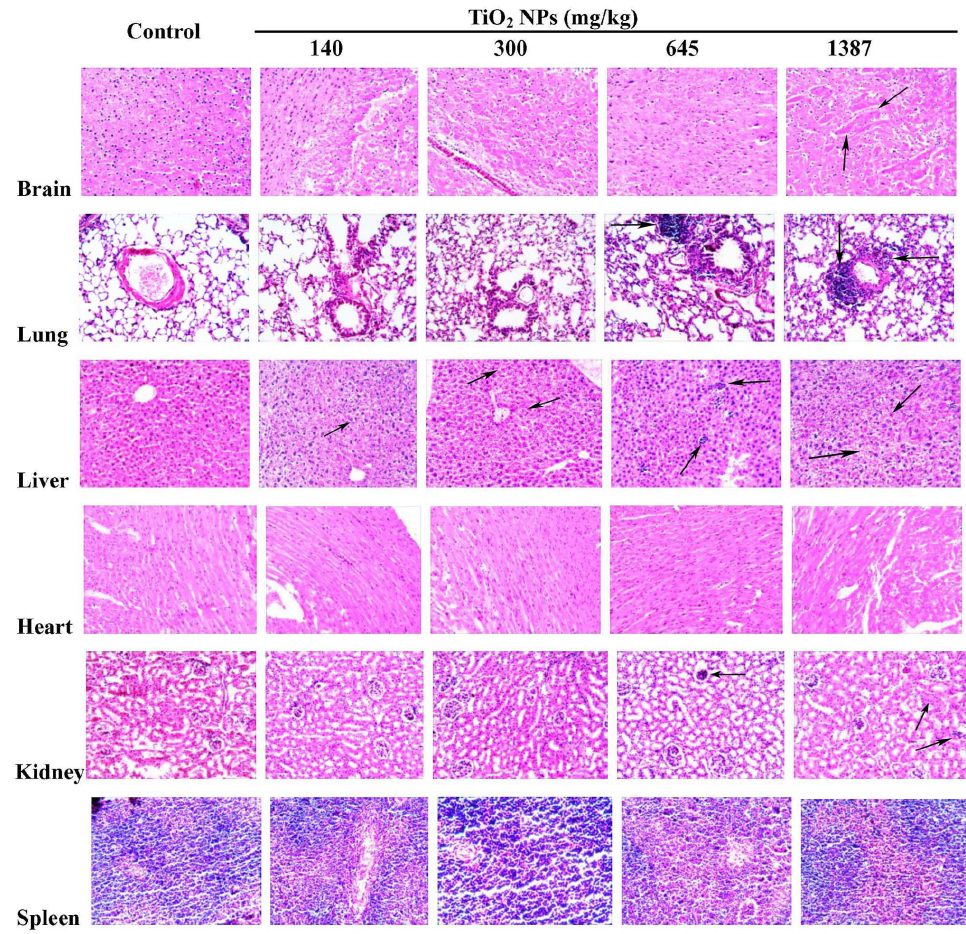
Figure 3. Pathological morphology of different tissues observed under microscope. In mice treated with TiO 2 NPs, neuronal cell degeneration was observed in the brain tissue; vacuoles were observed in the neurons of hippocampus and their number was increased in the high dose groups, which indicated fatty degeneration occurred in the hippocampus of brain tissue. In the lung tissues, perivascular infiltration of inflammatory cells, foamy cells as well as pulmonary fibrosis were observed; the granulomatous lesions were found at the doses of 645 and 1387 mg/ kg. At the doses of 140 and 300 mg/kg, TiO 2 NPs showed vacuolar degeneration in the liver. At 645 mg/kg, inflammatory cells were found in the bile ducts of the liver, and hydropic degeneration around the central vein and spotty necrosis of hepatocytes were also observed. At 645 and 1387 mg/ kg, multifocal lesions were observed in the liver. In the kidneys, swelling in the renal glomerulus was observed in TiO 2 NPs treated mice. In the spleen, minor lesions were observed due to increased proliferation of local macrophages. No obvious abnormality in histology was observed in the heart in TiO 2 NPs treated mice as seen under the microscope (400 6 ).